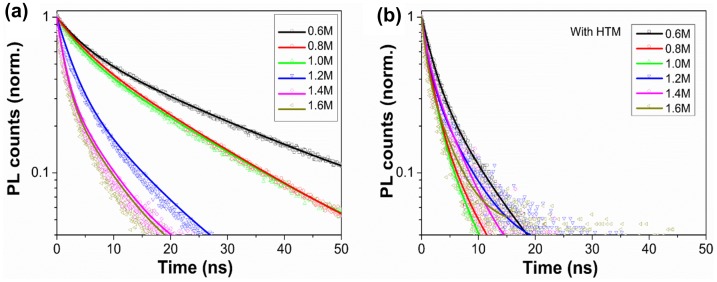
Time-resolved PL spectra of (a) FTO/bl-TiO2/mp-TiO2 /CH3NH3PbI3 films and (b) FTO/bl-TiO2/mp-TiO2/CH3NH3PbI3/HTM films as a function of C
(PbI2).